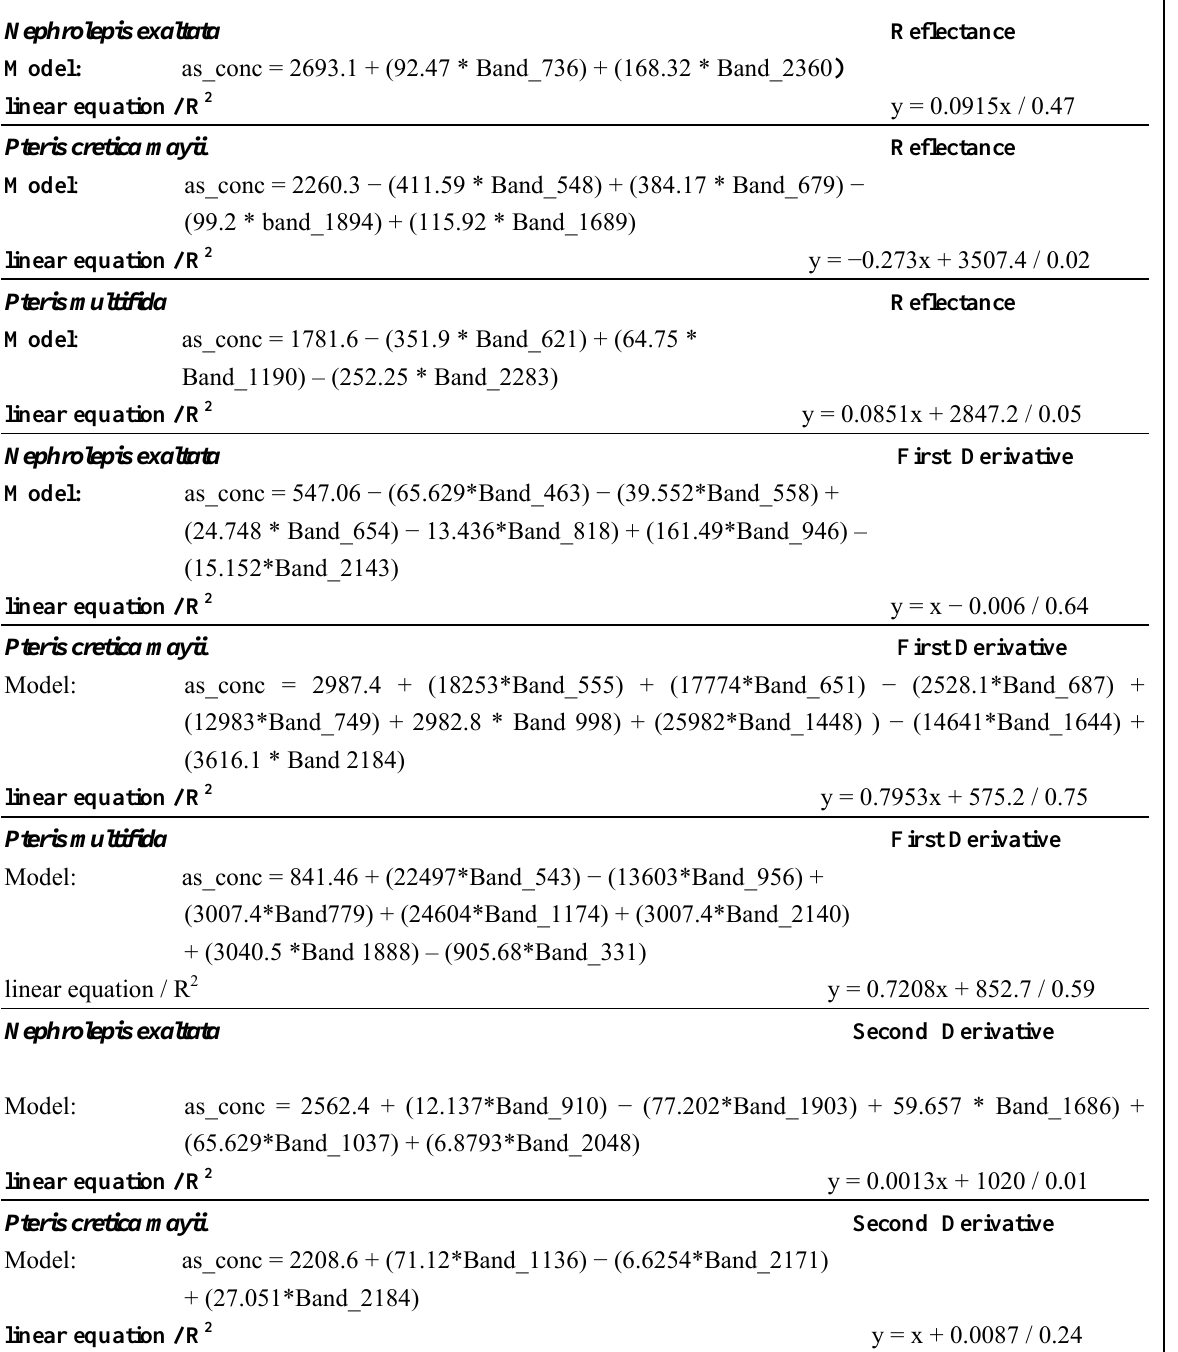
Table 4. Linear Models for Predicting Arsenic Concentration from Spectral